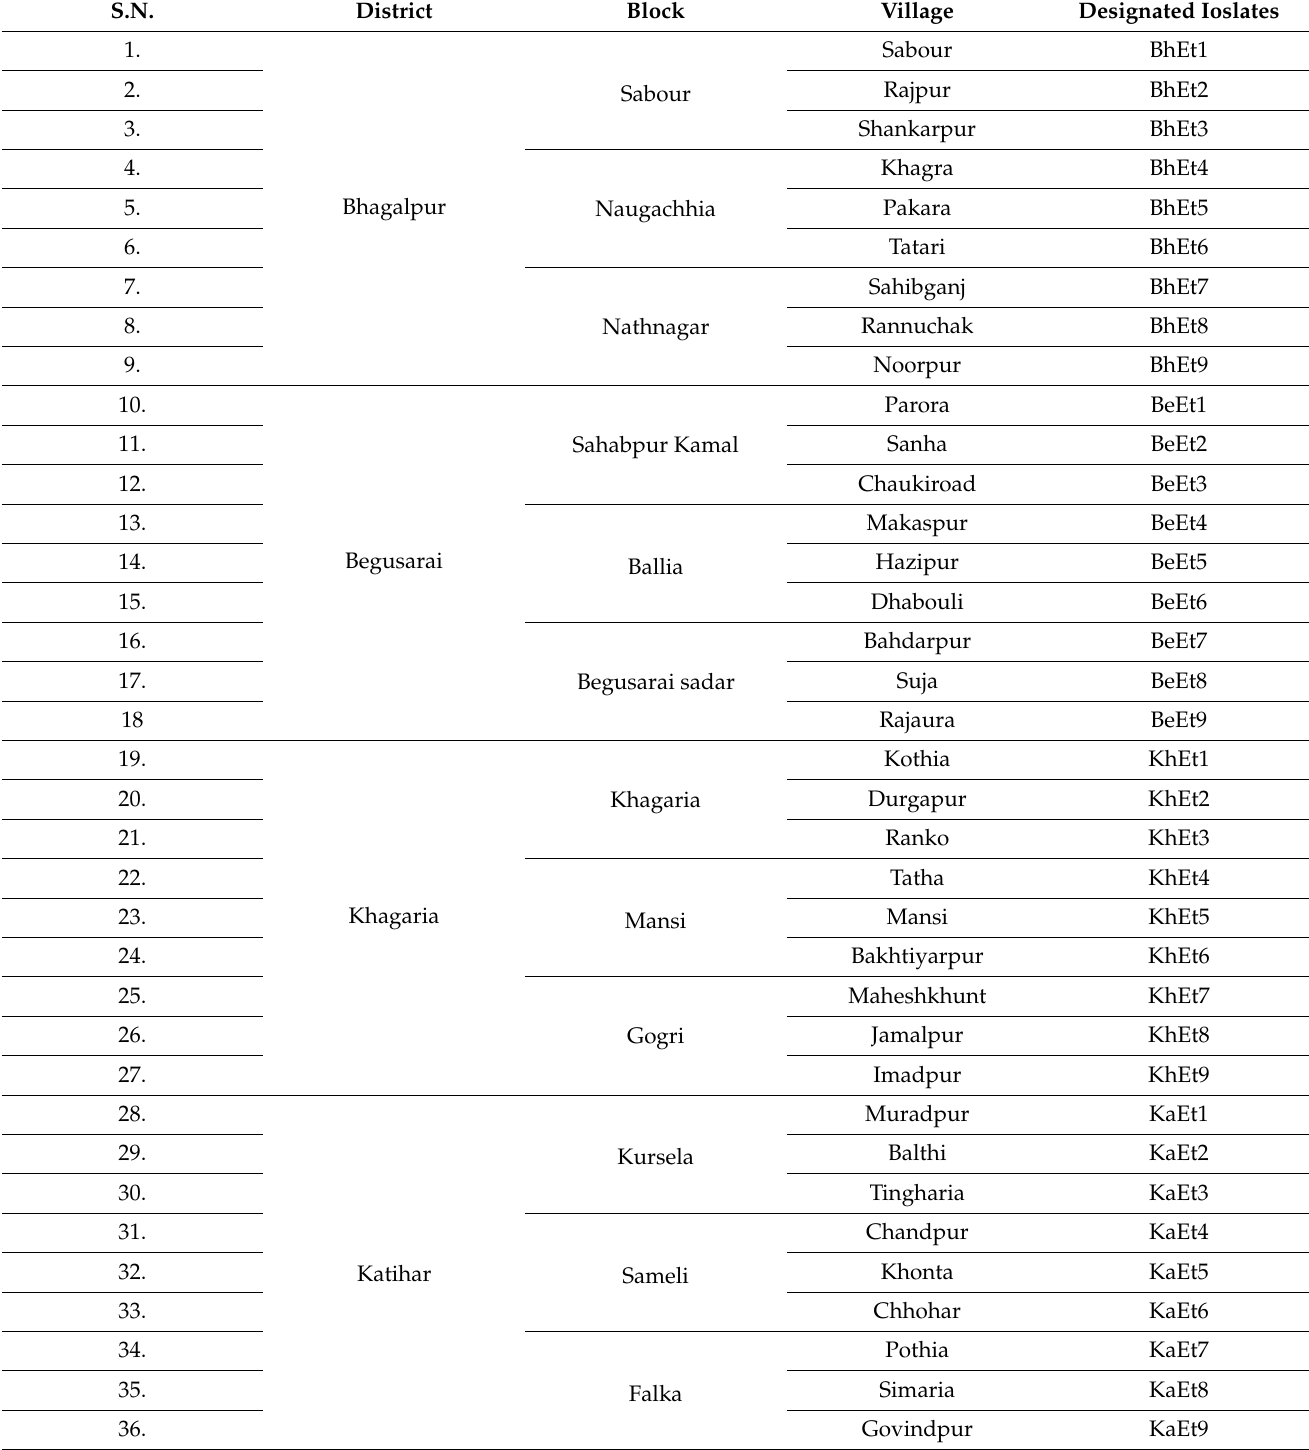
Table 1. Details of the places surveyed for collection of Northern corn leaf blight samples